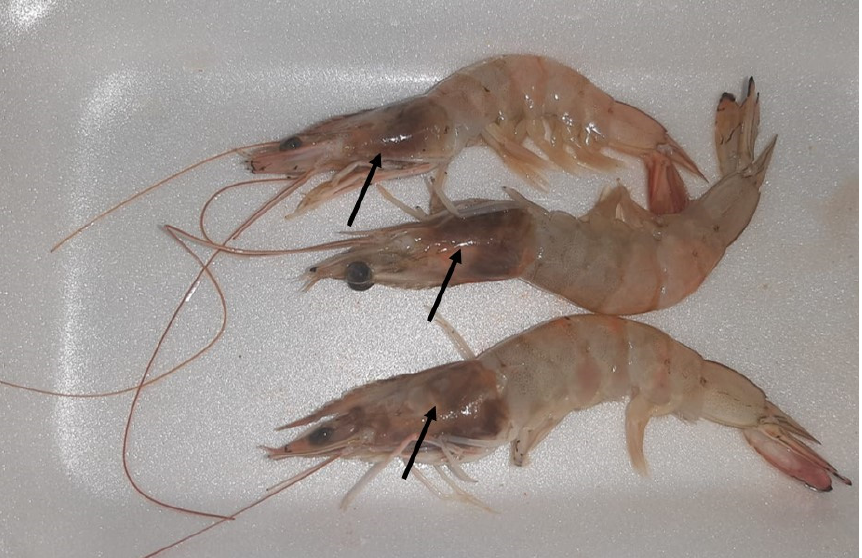
Figure 3. Gills of experimentally infected Litopenaeus vannamei by Fusarium solani showing noticeable black to brown melanated gills (black arrows).